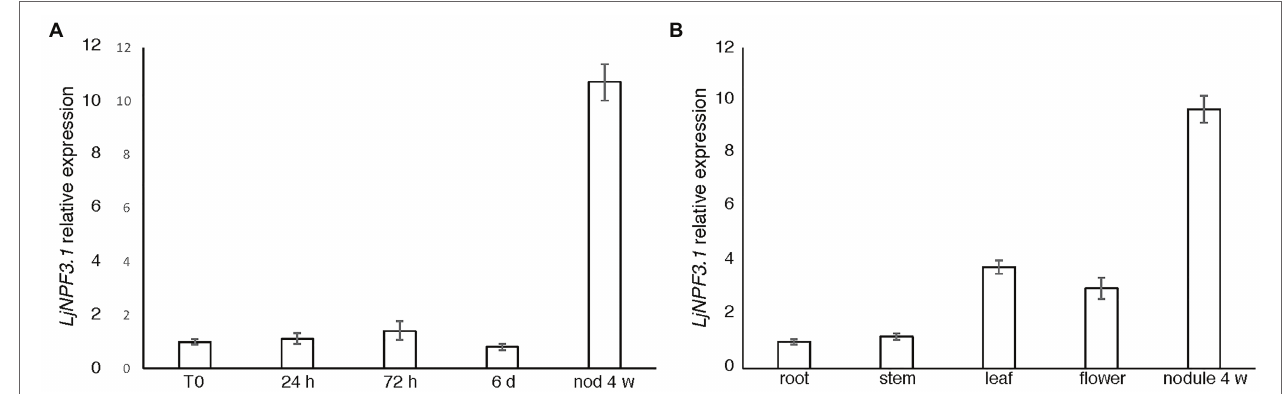
FIGURE 1 | LjNPF3.1 transcriptional regulation. (A) Time-course analysis in wild-type Lotus japonicus root and nodule tissues after Mesorhizobium loti inoculation. RNAs were extracted from roots of seedlings grown in N-starvation conditions at different times after inoculation (R0, 24 h, 72 h, 6 days, and 14 days) and from mature nodules (28 dpi). (B) Expression in different organs. RNAs were extracted 4 weeks after inoculation. Mature flowers were obtained from lotus plants propagated in the growth chamber. Expression levels obtained by quantitative real-time PCR (qRT-PCR) were normalized with respect to the internal control ubiquitin ( UBI ) gene and plotted as relative to the expression of T0 (A) and root (B) . Data bars represent the mean and SDs of data obtained with RNA extracted from three different sets of plants and three real-time PCR